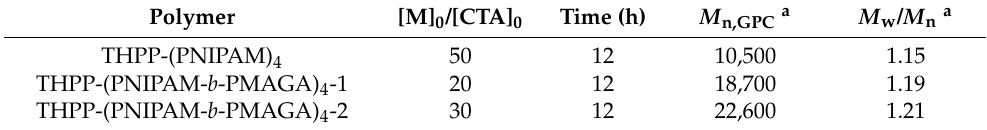
Table 1. Polymerization data of THPP-(PNIPAM) 4 and THPP-(PNIPAM- b -PMA GA) 4 .